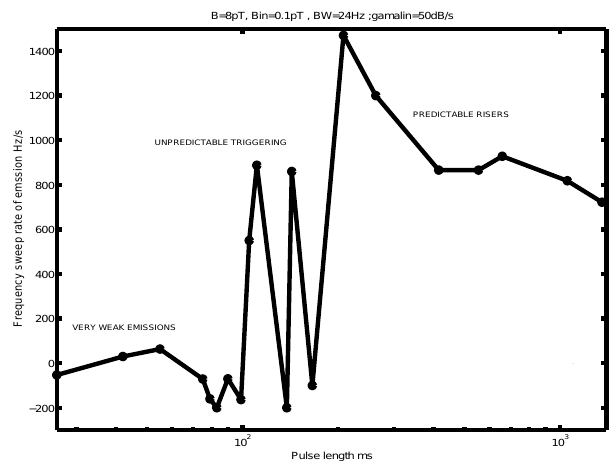
Fig. 16. Dependence of the sweep rate on the pulse length with a weaker linear growth rate of 50dB/s. Stable triggering only occurs when the pulse length exceeds 200ms in this